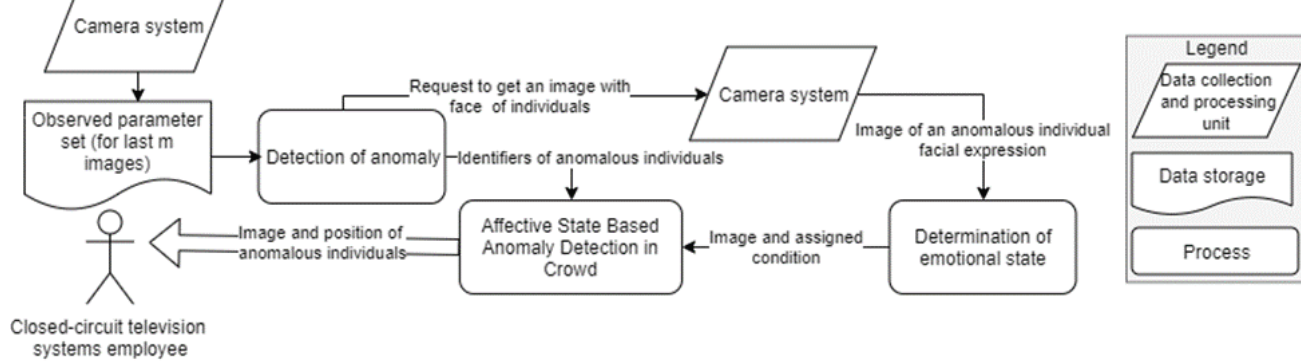
Fig. 1. The proposed approach